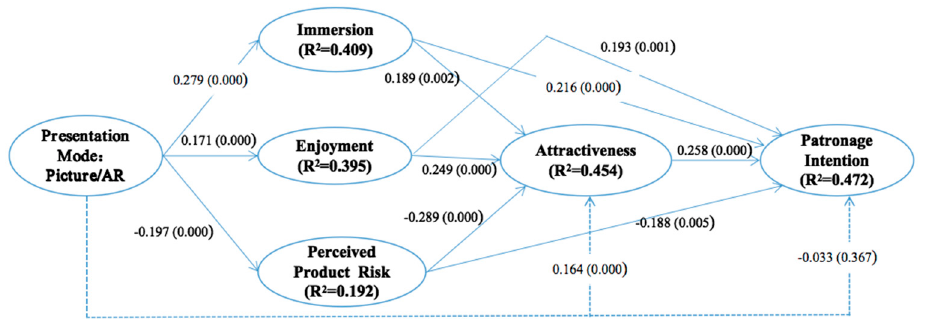
Figure 2. Main effects of the structural model.